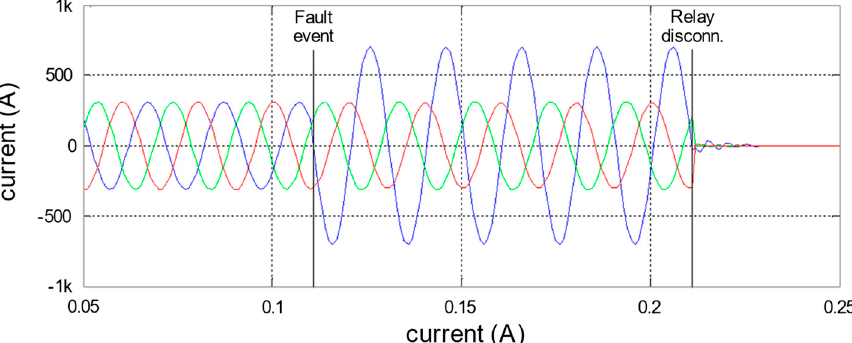
Figure 15. Example of a fault stages registered by a sensor node.